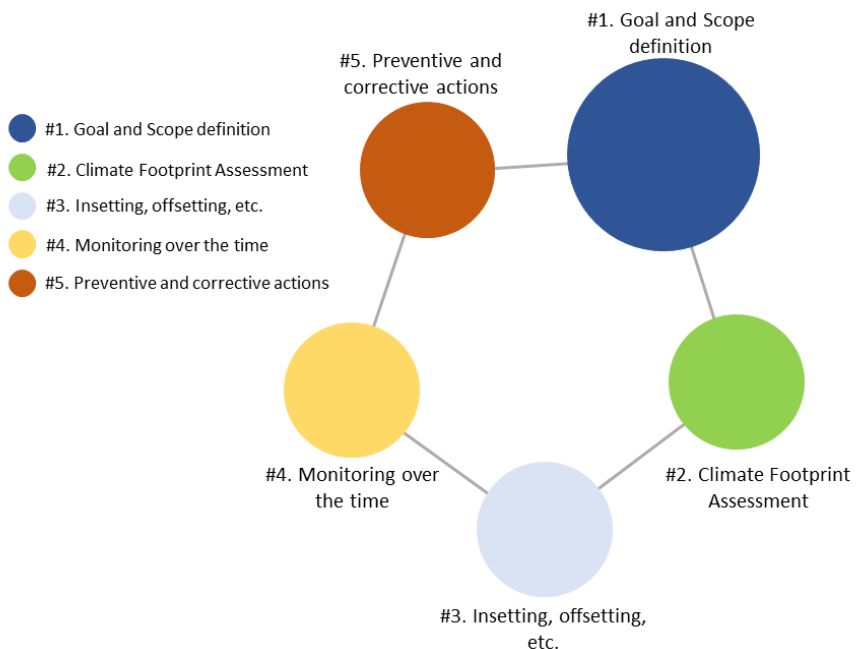
Figure 11. Workflow for defining net-zero climate emission districts.